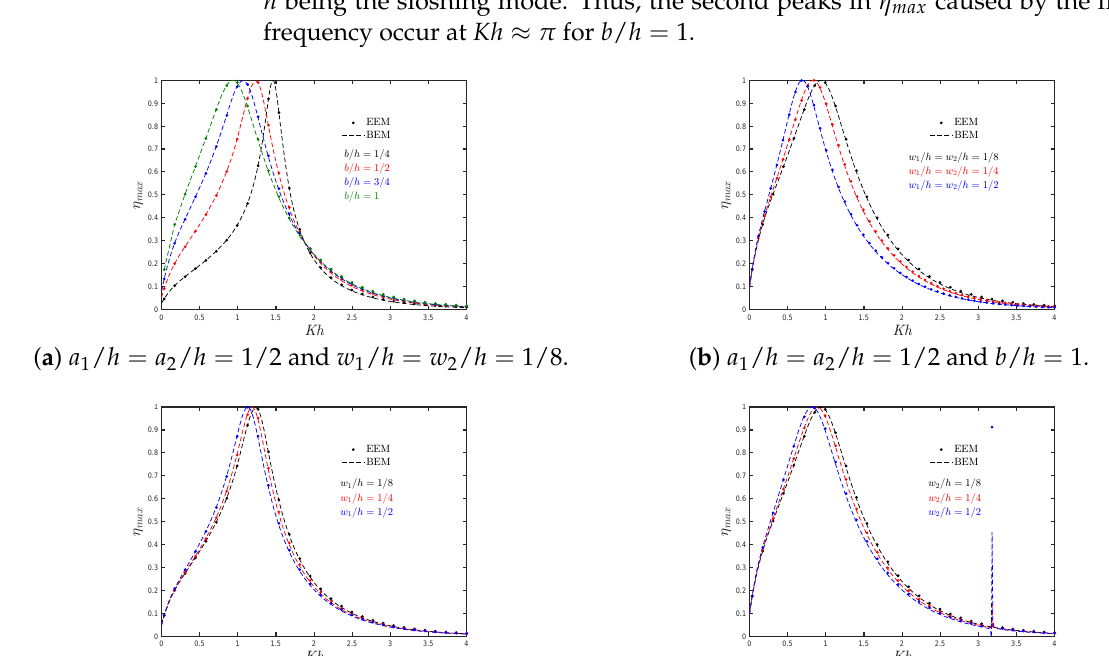
Figure 5. Maximum hydrodynamic efficiency η max versus the non-dimensional frequency Kh for different ( a ) lengths of the OWC chamber b / h ; ( b ) thickness of the rear and front walls, w 1 / h and w 2 / h , respectively; ( c ) thickness of the rear wall w 1 / h ; ( d ) thickness of the front wall w 2 / h